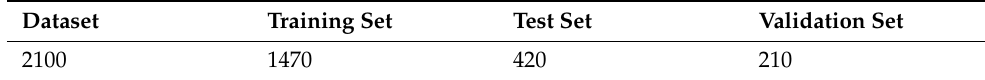
Table 1. Partitioning of the dataset in the experiment. Dataset Training Set Test Set Validation Set 2100 1470 420